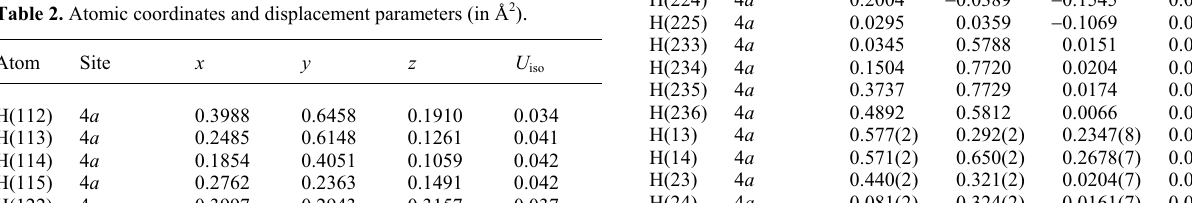
Table 2. Atomic coordinates and displacement parameters (in Å 2 ) .